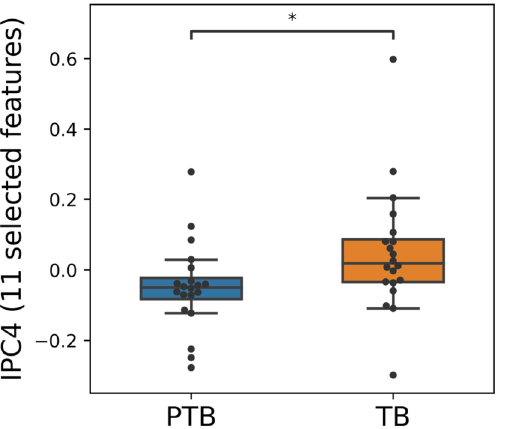
Figure 3. A select group of 11 metabolites in the cervicovaginal metabolome is associated with spontaneous preterm birth. Distribution of IPC4 components of women who delivered spontaneously preterm and term when 11 features are selected. Box, IQR; whiskers, 1.5*IQR; center line, median; * Mann–Whitney U p < 0.05.